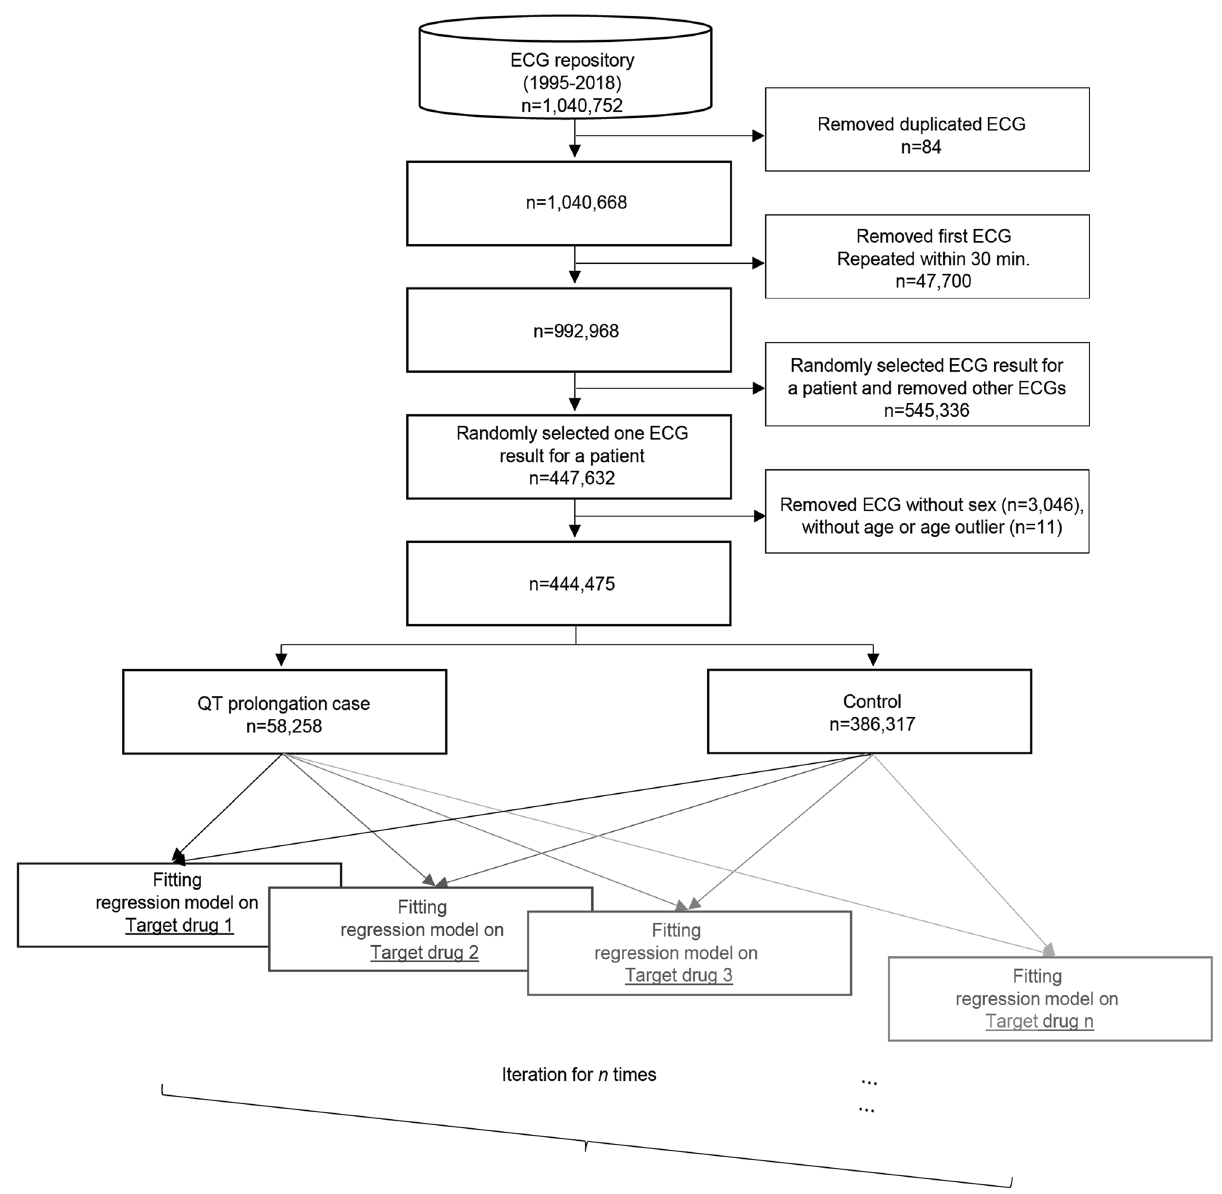
Figure 1. Overview of the study process. Among 1,040,752 ECG results, 992,968 ECGs that have no duplicated or repeated measurements were extracted and selected one ECG for one patient with sex and age information with no age outlier. Total of 444,475 ECG results were enrolled and divided into QT prolongation case (n = 58,258) vs. control (n = 386,317). Multiple logistic regression analysis was repeated iteratively for each target